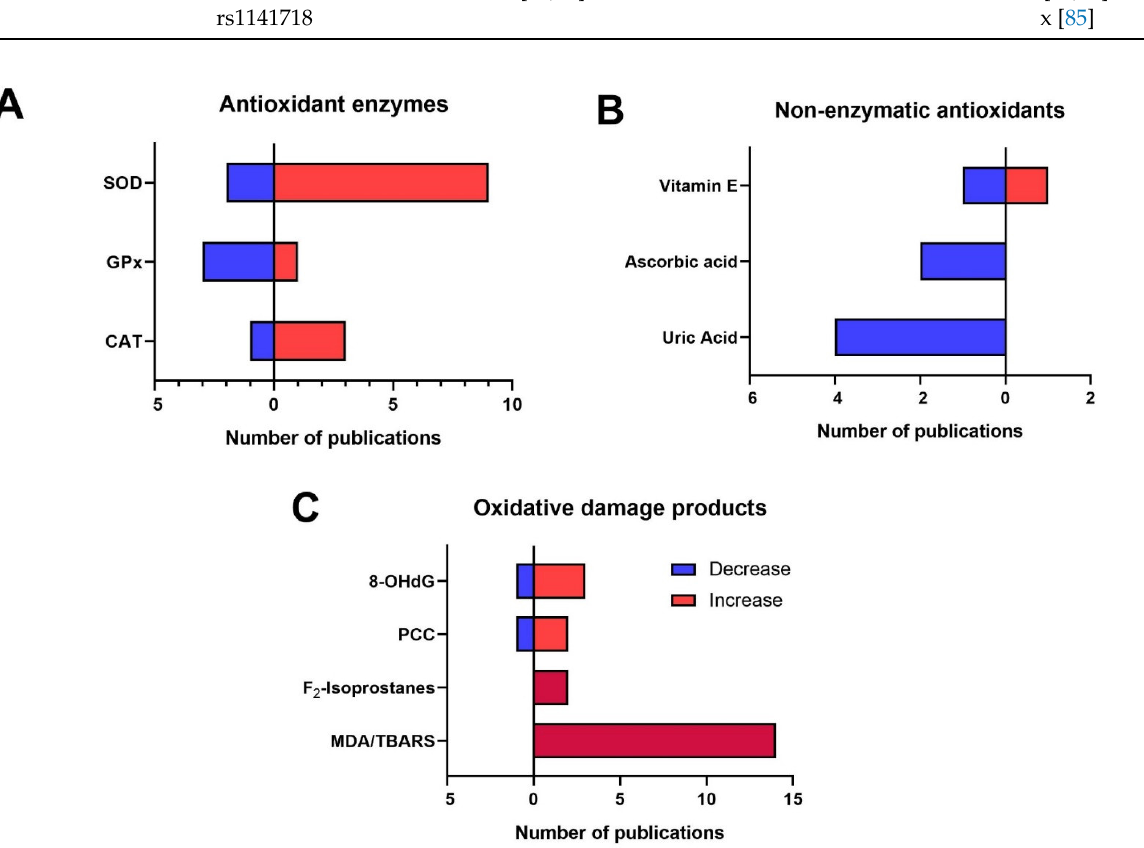
Figure 2. Number of publications according to modifications evidenced in main peripheral biomarkers of oxidative stress in unspecified MDD patients compared to healthy controls. MDD: